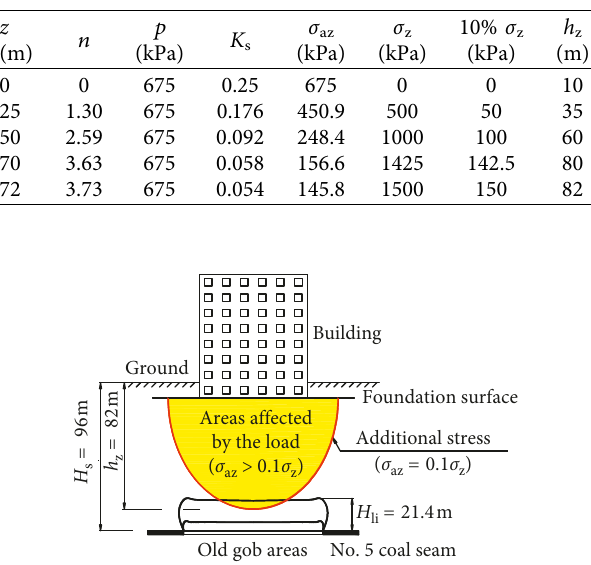
Figure 6: Profile map of apparent resistivity contours of Transient Electromagnetic Geophysical Exploration: (a) 1080 survey line; (b) 1160 survey line; (c) 1240 survey line; (d) 1320 survey line. Table 4: Depth affected by the load.